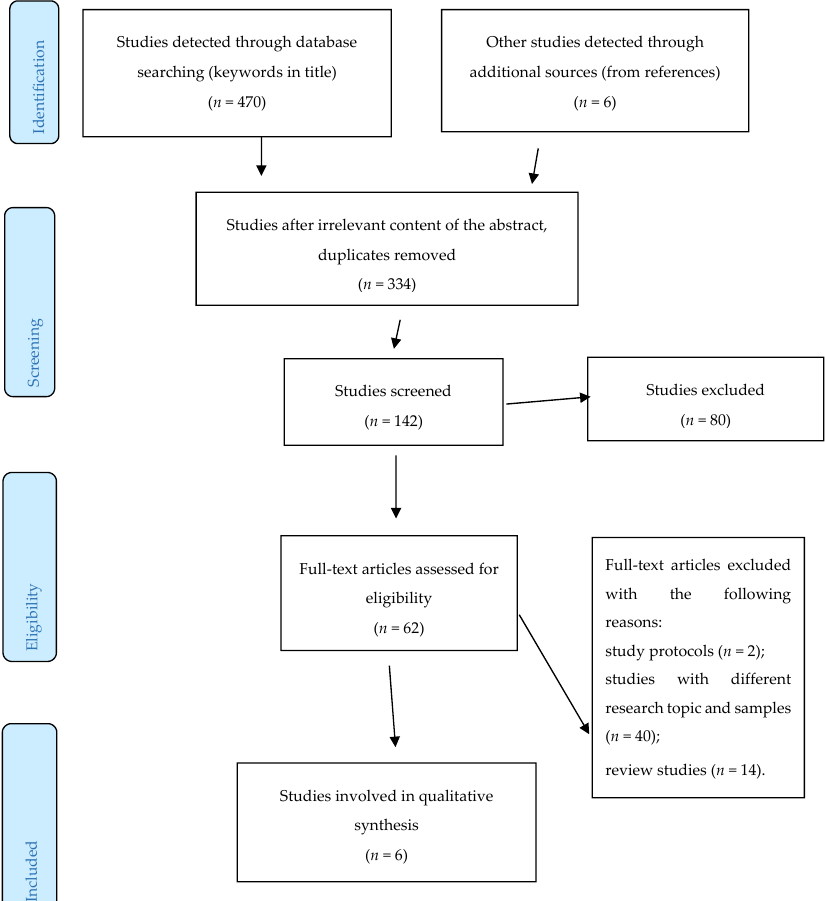
Figure 1. An overview of the selection procedure.